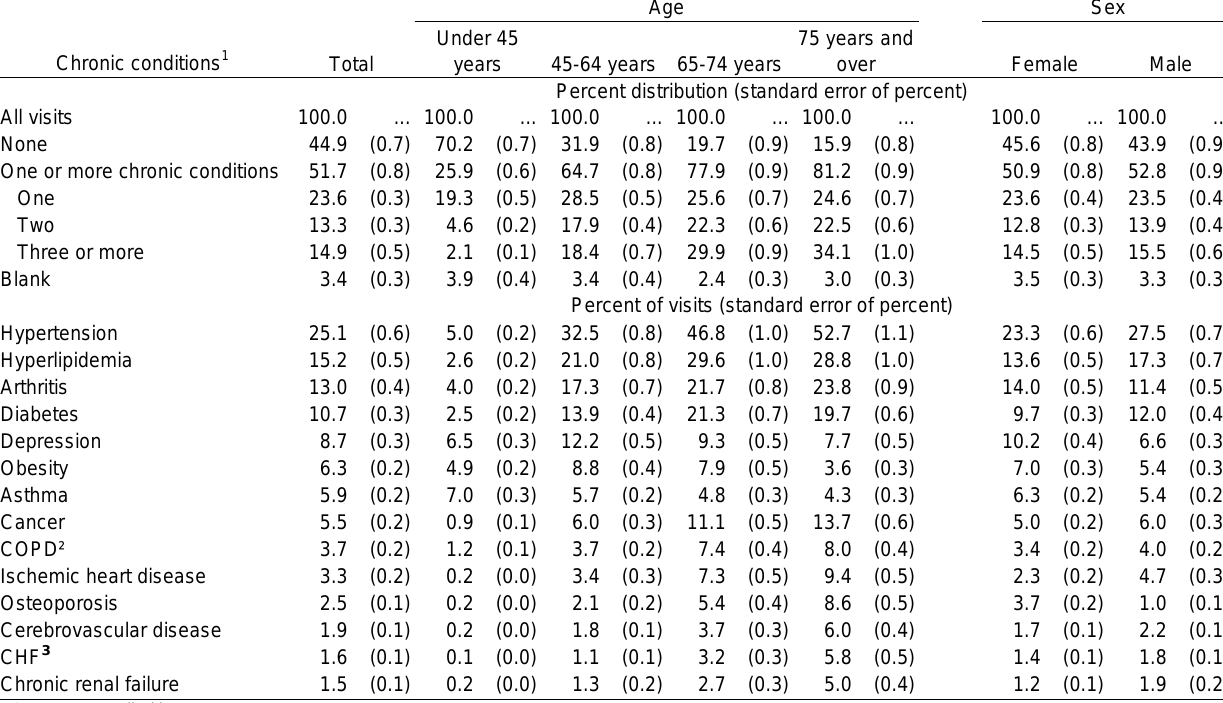
...Category not applicable. ¹Presence of chronic conditions was based on the checklist of chronic conditions and reported diagnoses. Combined total visits by patients with chronic condtions (percent of visits) exceeds 100% because more than one chronic condition may be reported per visit. ²COPD is chronic obstructive pulmonary disease. 3 CHF is congestive heart failure. NOTE: Numbers may not add to totals because more than one chronic condition may be reported per visit. SOURCE: CDC/NCHS, National Ambulatory Medical Care